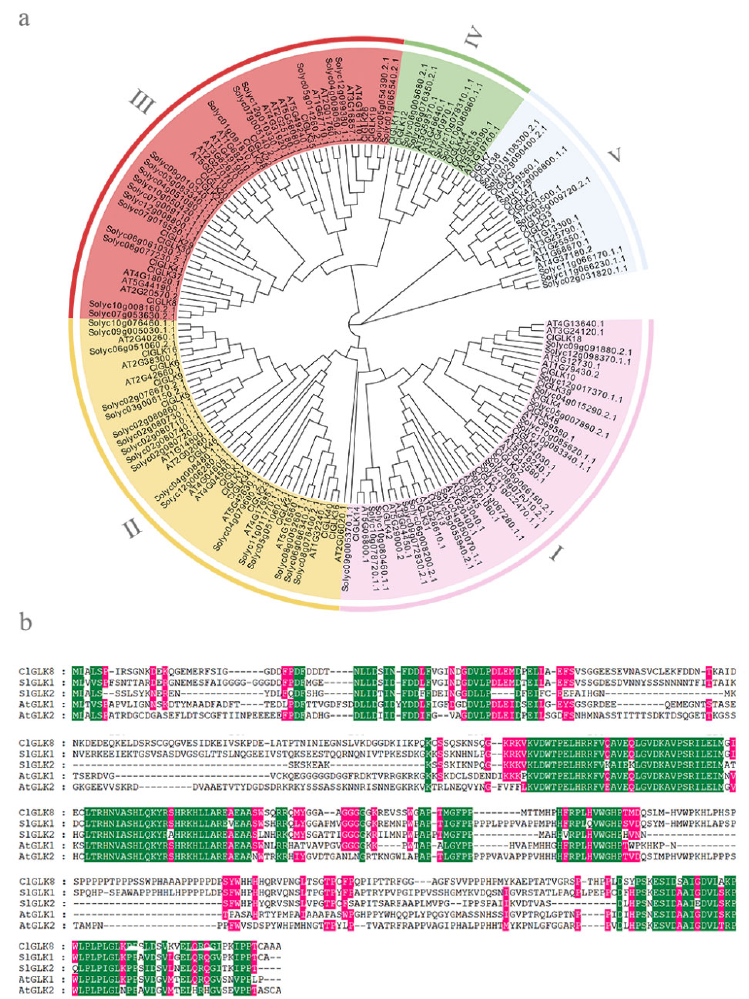
Figure 2 . Phylogenetic analysis and sequence alignment of GLKs in watermelon, Arabidopsis, and tomato. ( a ) Phylogenetic tree of GLK proteins in watermelon, Arabidopsis, and tomato. ( b ) Sequence alignment of AtGLK1, AtGLK2, SlGLK1, SlGLK1, and ClGLK8.